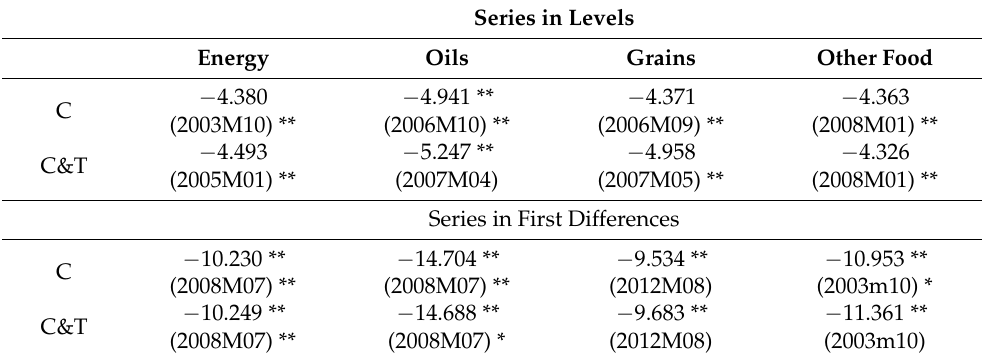
Table 2. Zivot–Andrews unit root